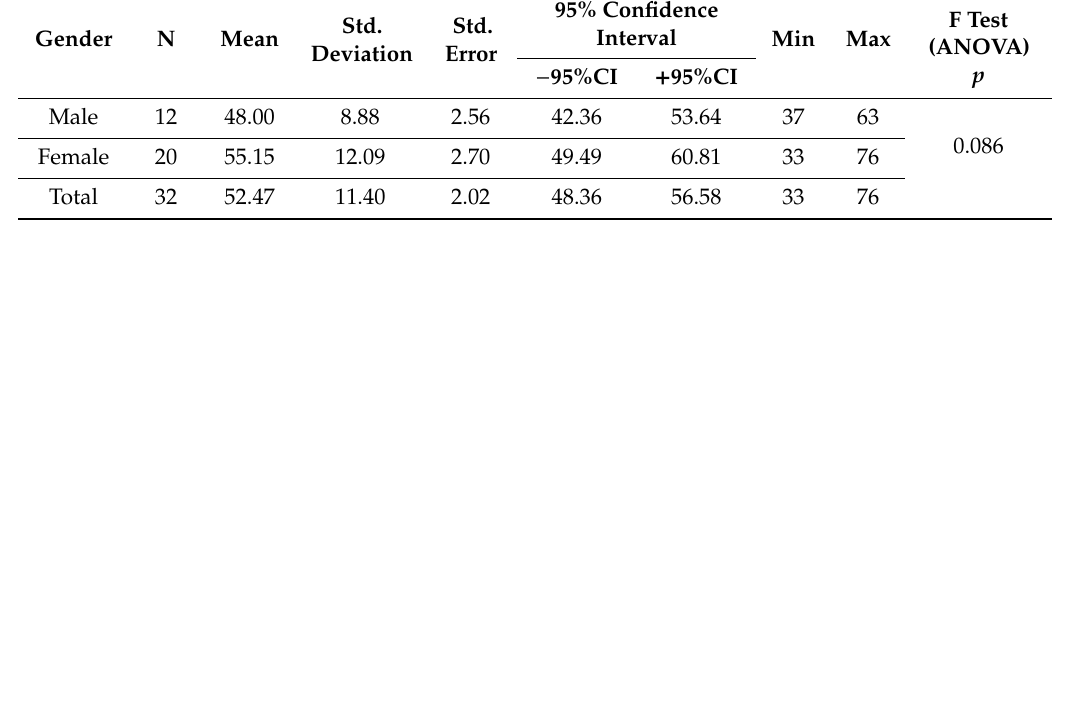
Figure 5. Global score histogram.